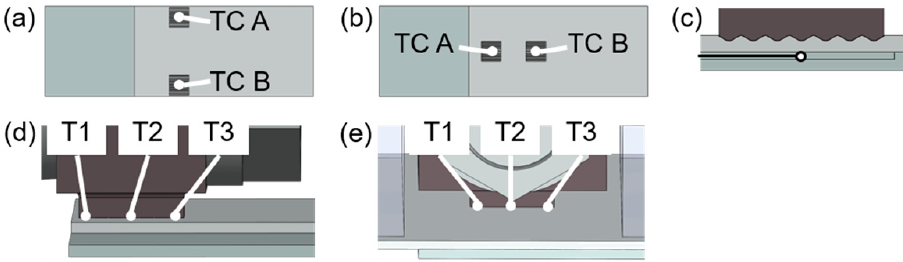
Figure 5. Schematics illustrating the temperature measurement setup. Thermocouple placements for ( a ) parallel configuration; ( b ) series configuration and ( c ) inside the weld cross-section, as well as thermal imaging spots for ( d ) parallel and ( e ) series configuration.